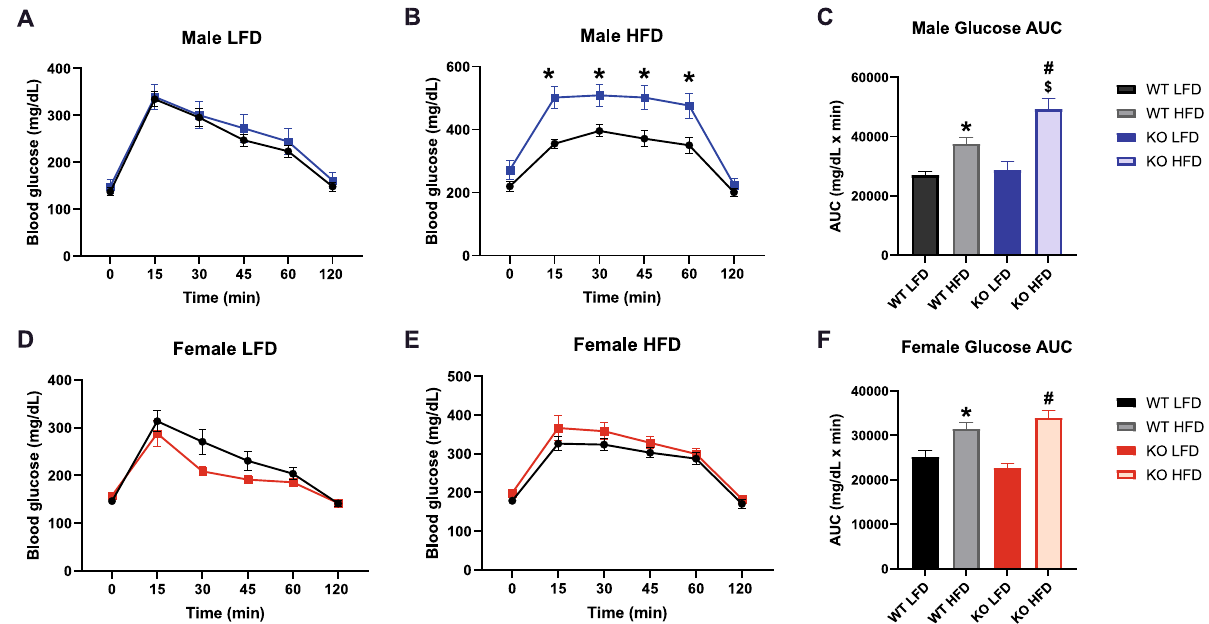
Figure 2. Glucose homeostasis is impaired in male GPR19 KO mice following exposure to a high fat diet. Male and female wildtype or GPR19 KO mice were fed a low-fat diet (LFD) and subject to an intraperitoneal glucose tolerance test (IPGTT). The same mice were then placed on a high-fat diet (HFD) for 10 weeks, after which a repeat IPGTT was performed. ( A–C ) LFD, HFD, and area under the curve (AUC) analysis for male mice. ( D–F ) LFD, HFD, and area under the curve (AUC) analysis for female mice. * P < 0.05 versus WT LFD, # P < 0.05 versus KO LFD, $ P < 0.05 versus WT HFD, N =